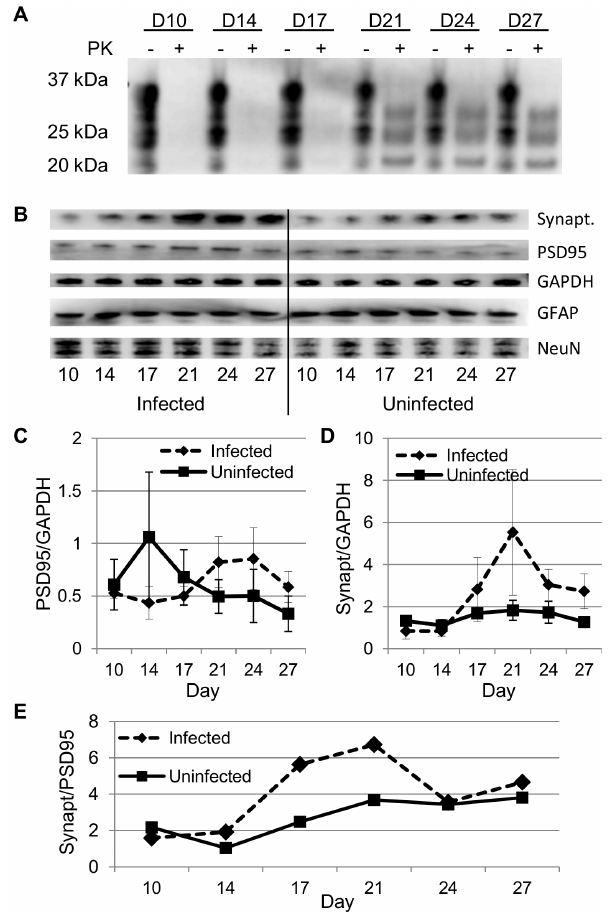
Figure 5. Immunoblots of RML-infected and uninfected cerebellar slice cultures from tga20 mice at early time points. A) Representative immunoblot of PrP Sc in infected slice cultures before ( 2 ) and after ( + ) proteinase K (PK) digestion. IPC1 antibody was the primary antibody. 4 of 5 experiments first detected PrP Sc at day 21, 1 was detected by day 17. Undigested samples were diluted by 10x before loading. B) 2–3 slices were collected at days 10 through 27, normalized for total protein by BCA assay, and probed for post-synaptic density 95 (PSD95), pre-synaptic synaptophysin (synapt.), GAPDH (protein loading control), GFAP (astrocyte marker) and NeuN (neuronal marker). C) Levels of PSD95, normalized to GAPDH, in infected and uninfected cultures at weekly time points. Differences were not statistically significant. D) Levels of synaptophysin, normalized to GAPDH, in infected and uninfected cultures at weekly time points. Differences were not statistically significant. E) Ratios of GAPDH- normalized synaptophysin/PSD95 are shown for infected and uninfect- ed cultures at weekly time points. Each data point represents a single ratio from averages from all